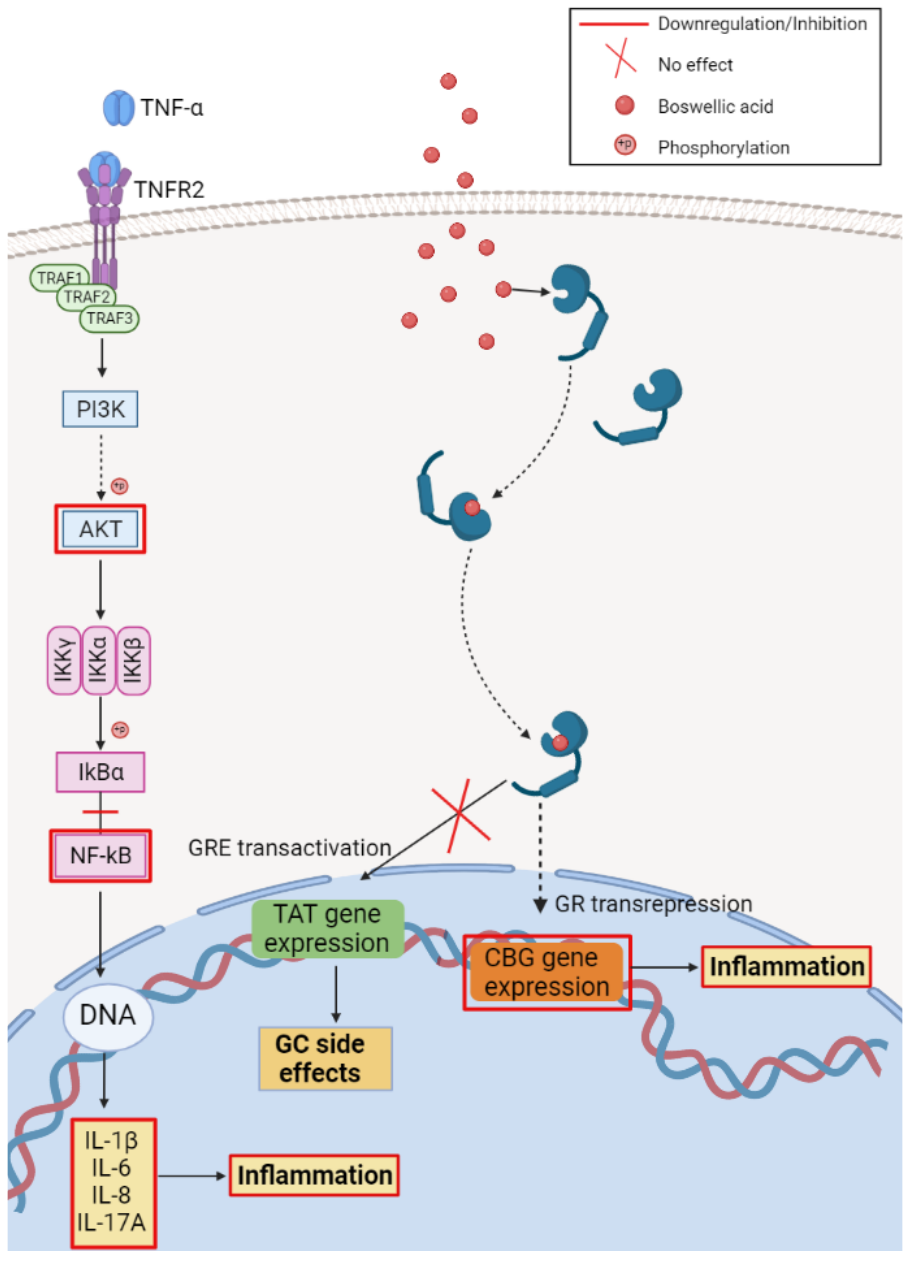
Figure 8. Schematic representation of the reported anti-inflammatory mechanisms of boswellic acid; key signaling pathways targeted. Created with BioRender.com (accessed on 23 June 2022).